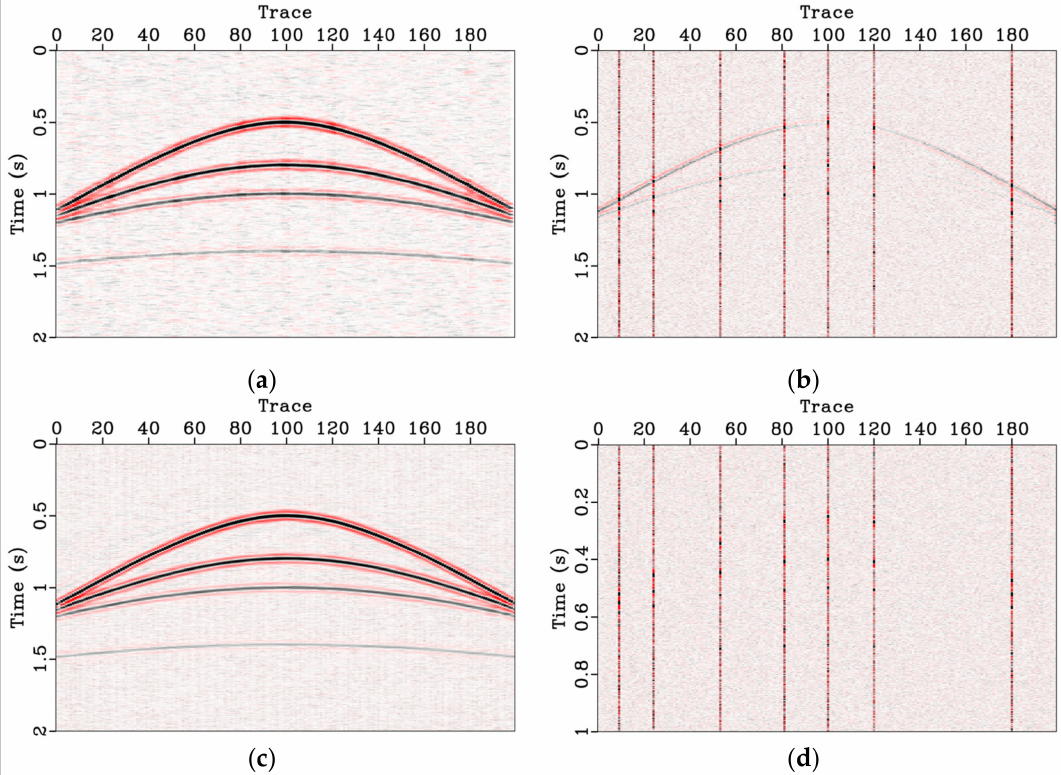
Figure 6. A comparison of denoising performance. ( a ) The denoised results of median filtering (SNR = 6.56 dB, PSNR = 17.37 dB). ( b ) Removed outlier noise. ( c ) The denoised results of the proposed method (SNR = 8.48 dB, PSNR = 25.72 dB). ( d ) Removed outlier and random